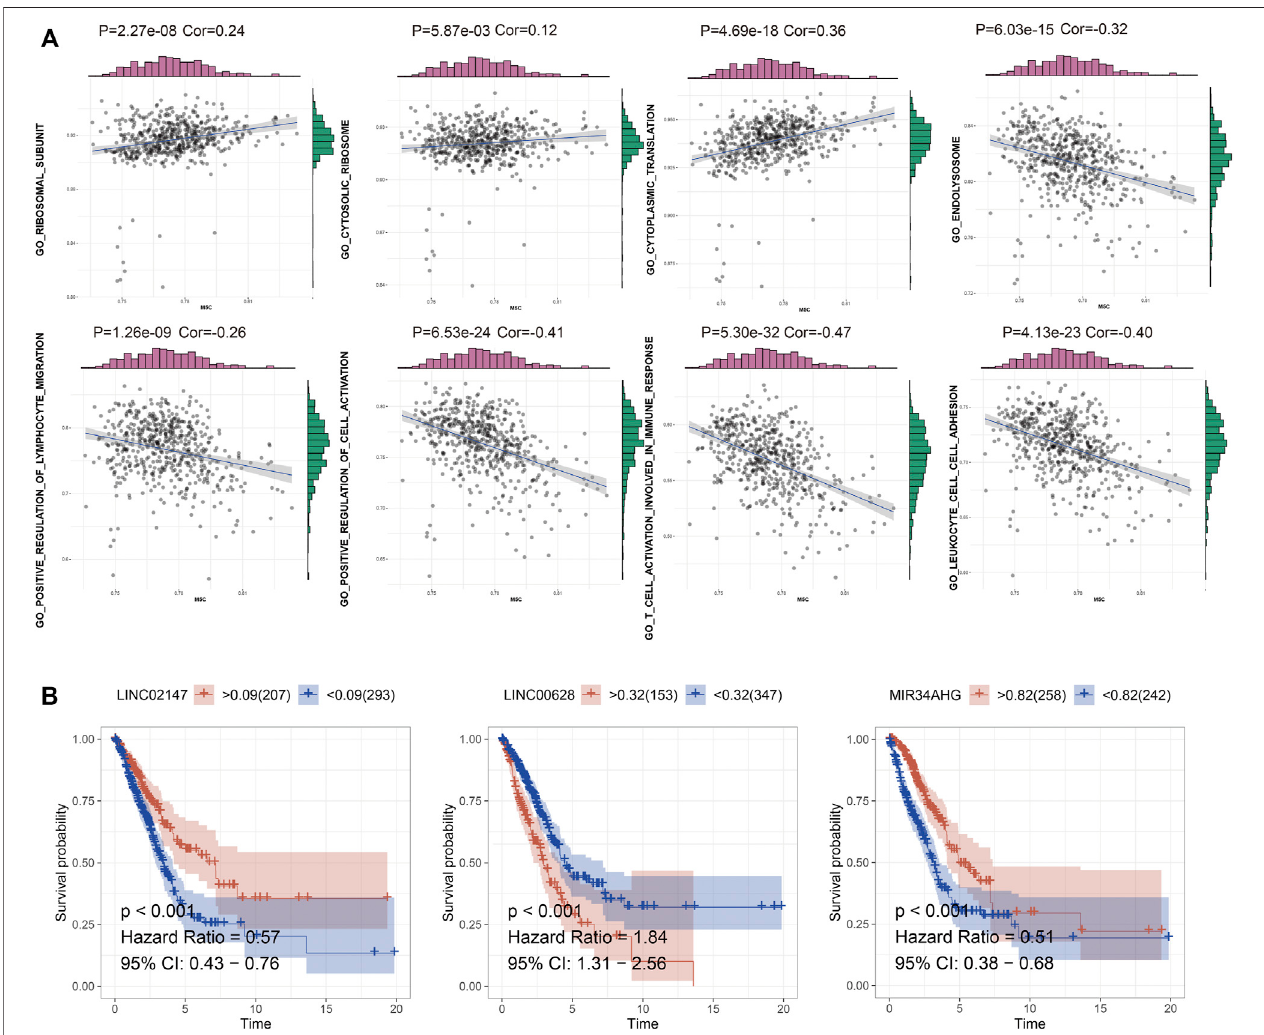
FIGURE 3 | (A) GSVA of m5C RNA methylation dataset and enriched functions in C1, C2, and C3. (B) The survival curve of the LINC02147, LINC00628, and MIR34AHG.